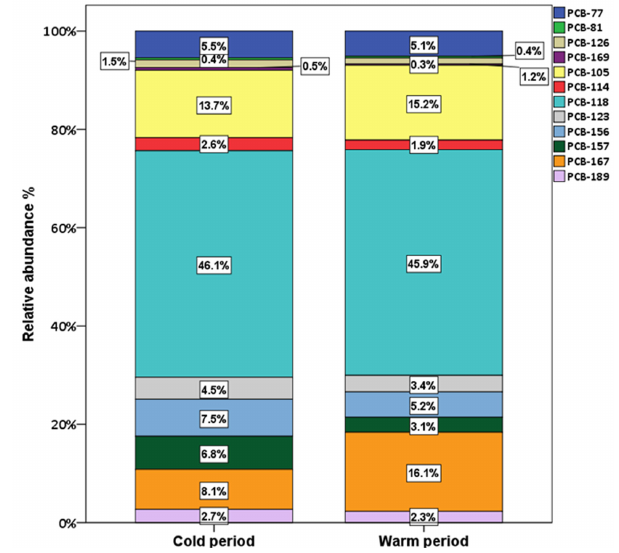
Figure 8. Relative abundance among dlPCB congeners for the cold and warm periods.